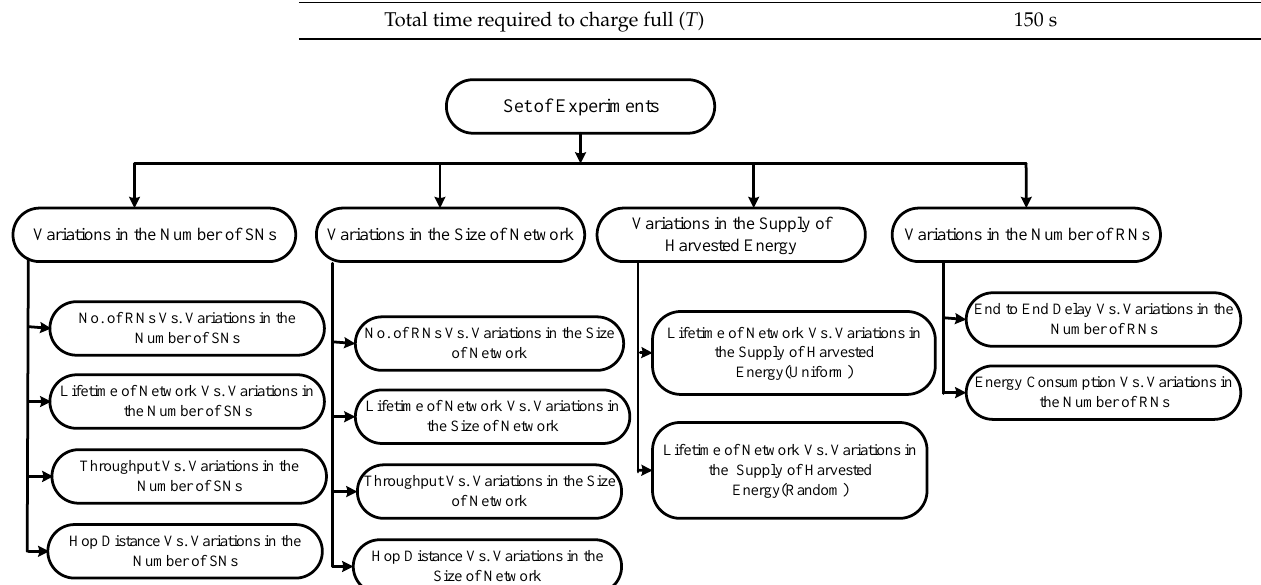
Figure 4. Methodology adopted for conducting the set of experiments.